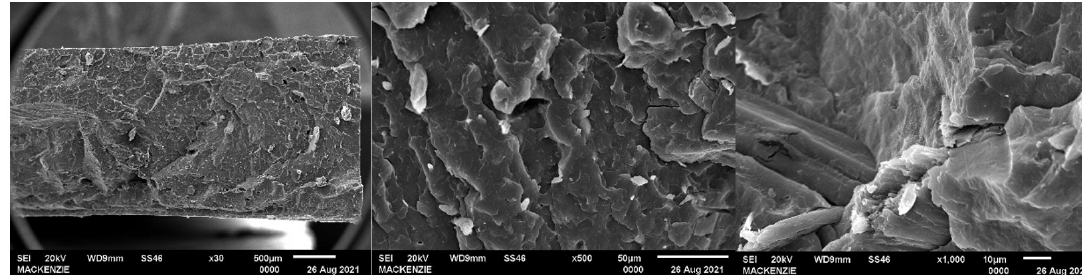
Figure 9. SEM image of the PP with 15wt% fiber (30, 500, and 1000 times magnification).